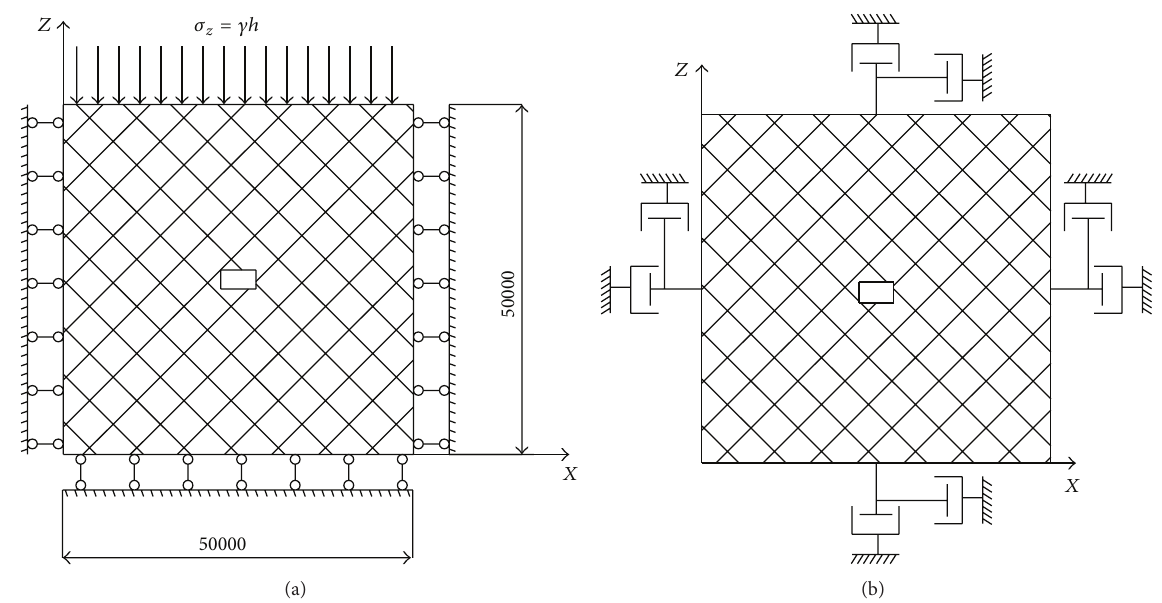
Figure 3: Boundary conditions of the static solution and dynamic solution; (a) boundary conditions of the static model; (b) boundary conditions of the dynamic